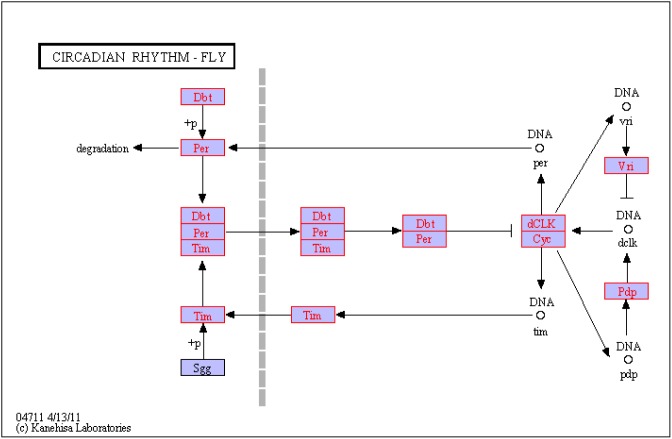
The KEGG PATHWAY is ‘ko 04711’ with term ‘Circadian rhythm - fly’.